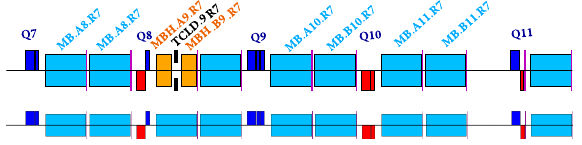
FIG. 16. Run 3 (top) and run 2 (bottom) layouts of the IR7 DS for B1, with and without the new TCLD collimators.